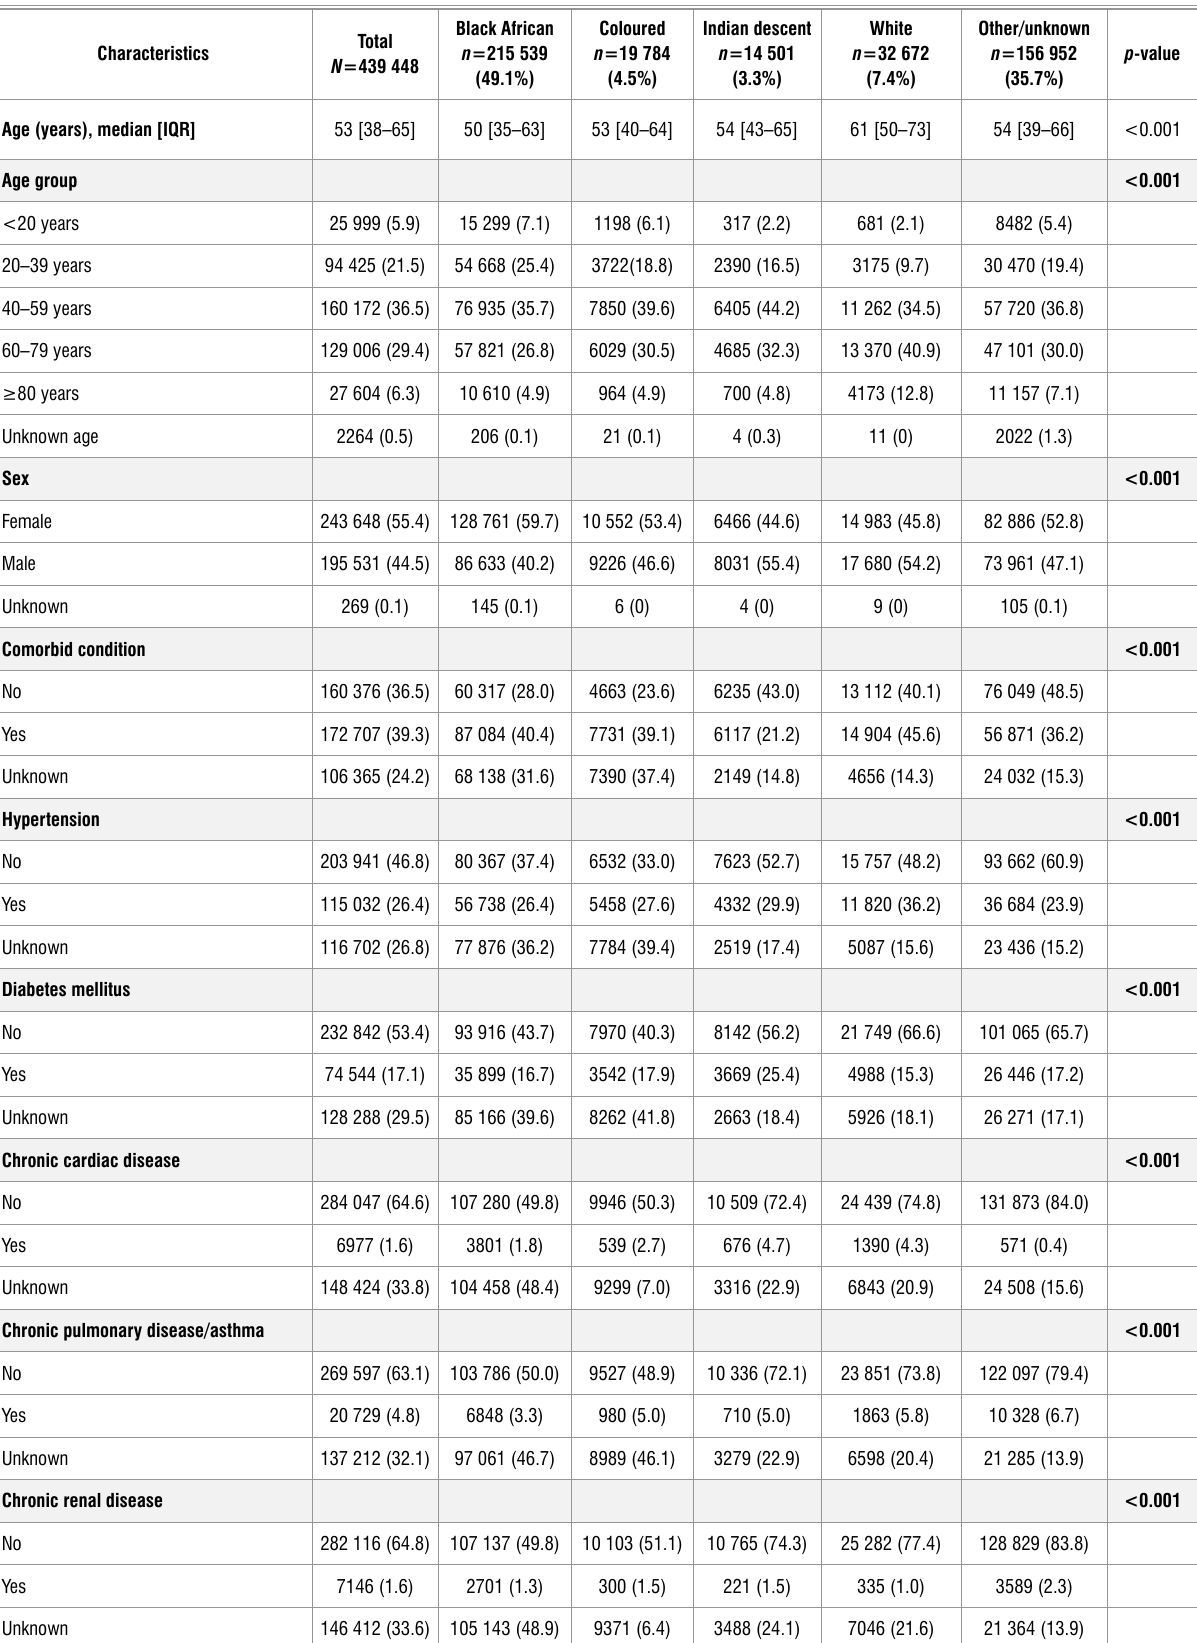
Table 1: Characteristics of in-hospital COVID-19 patients by race group in South Africa, 5 March 2020 to 8 January 2021